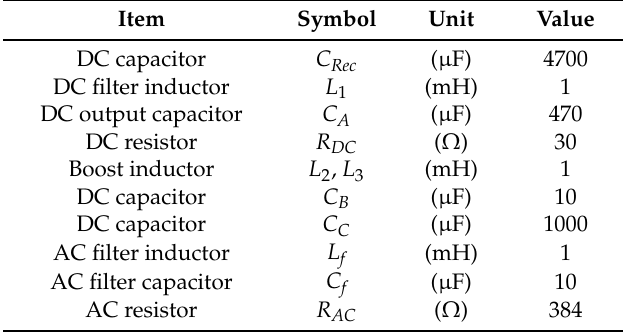
Table 1. Circuit component specifications. DC: direct current; AC: alternating current.